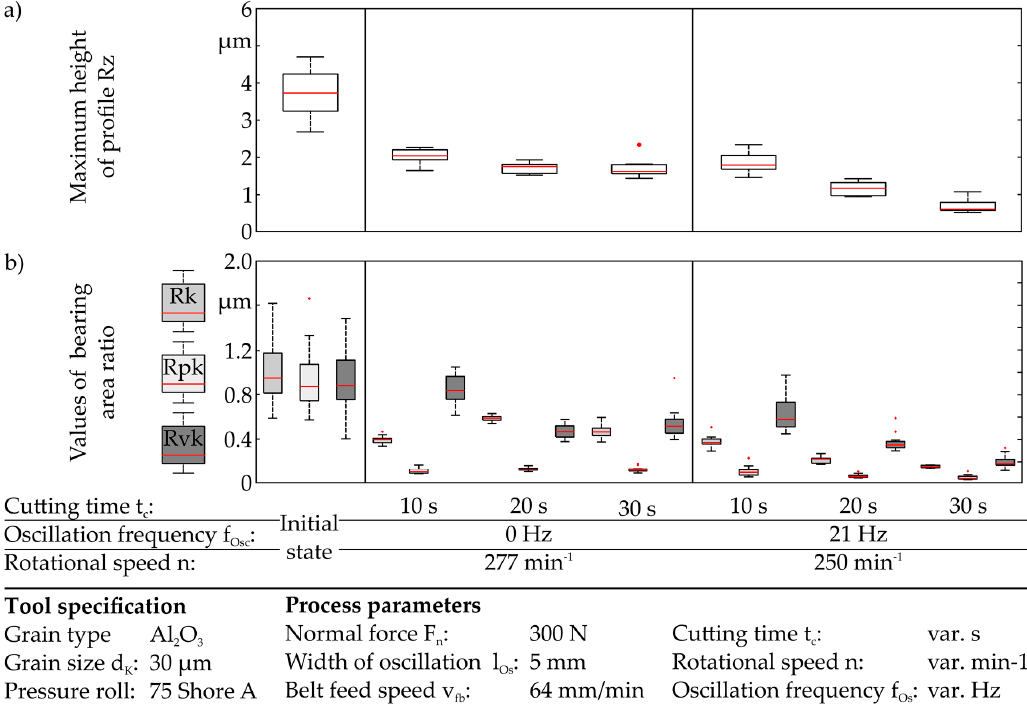
Figure 6. Surface parameters of the initially structured surface and the subsequently microfinished surface using the grain size d K = 30 µm. ( a ) Rz; ( b ) Rk, Rpk and Rvk.